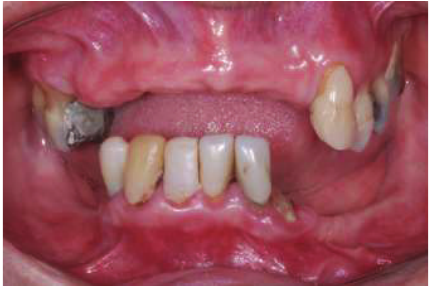
Figure 1: Initial clinical features.